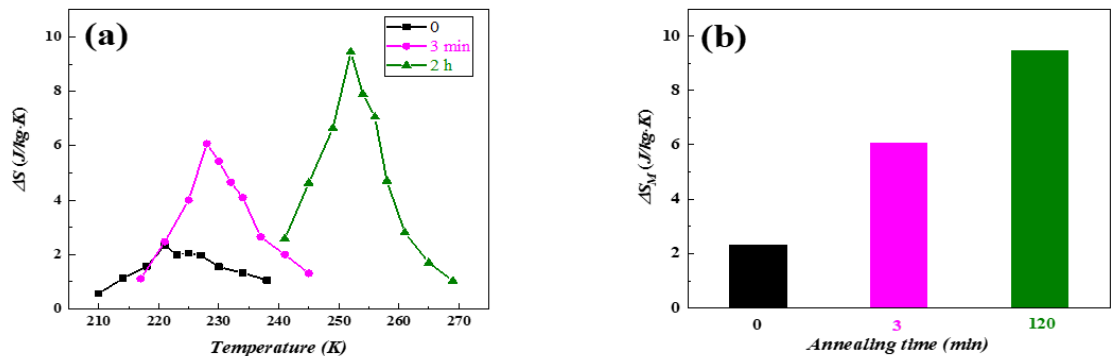
Figure 8. ( a ) ∆ S − T curves and ( b ) histogram of the maximum isothermal magnetic entropy of LaFe 11.5 Si 1.5 C 0.2 ribbons at a wheel speed of 35 m/s annealed at 1273 K for different times.